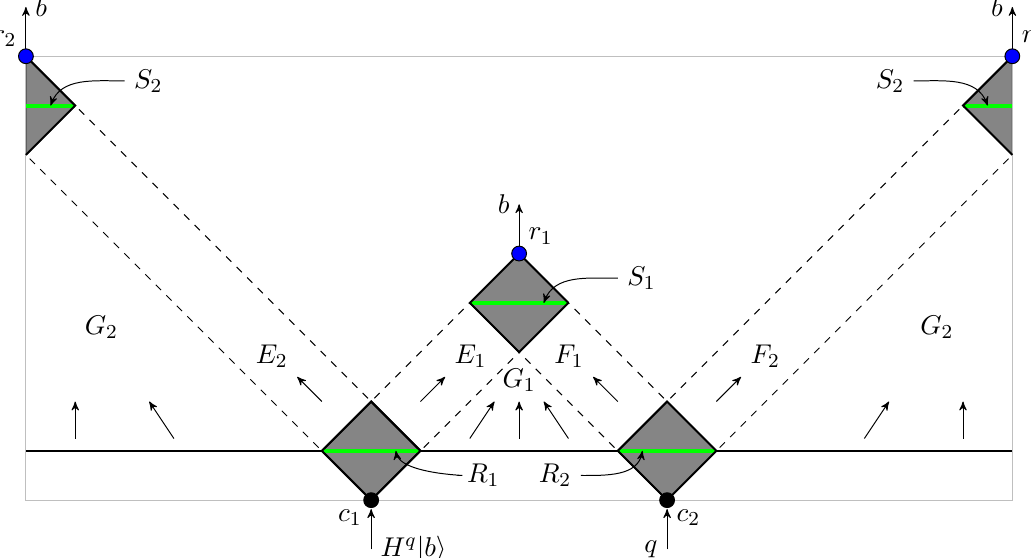
Figure 10. The ^ B 84 quantum task. At c 2 Alice receives the classical bit q , and at c 1 Bob hands to Alice the quantum system A which is in the state j (cid:9) + i BA = 1 p H q (cid:10) I ( j 00 i + j 11 i ), with B held 2 by Bob. Bob will measure the B system and obtain outcome b . Alice’s goal is to hand b 0 and b 0 1 2 over at r 1 and r 2 such that b = b 0 . The quantum systems E 1 ; E 2 ; F 1 ; F 2 ; G 1 ; G 2 used in the proof of i theorem 4 are shown. E 1 and E 2 originate from region R 1 and are sent to S 1 and S 2 respectively. F 1 and F 2 originate in R 2 and are sent to S 1 and S 2 respectively. G 2 is the system in the region to the right of R 2 and left of R 1 which is sent to S 2 . Similarly G 1 is in the region to the right of R 1 and left of R 2